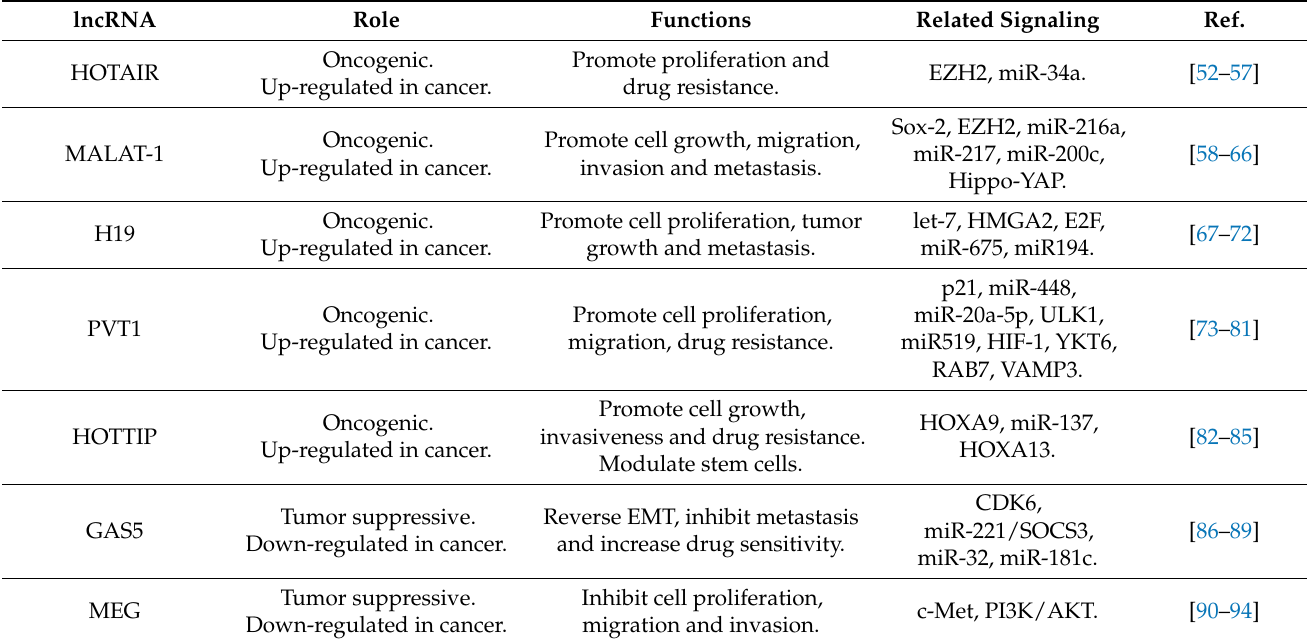
Table 1. Major lncRNAs in pancreatic